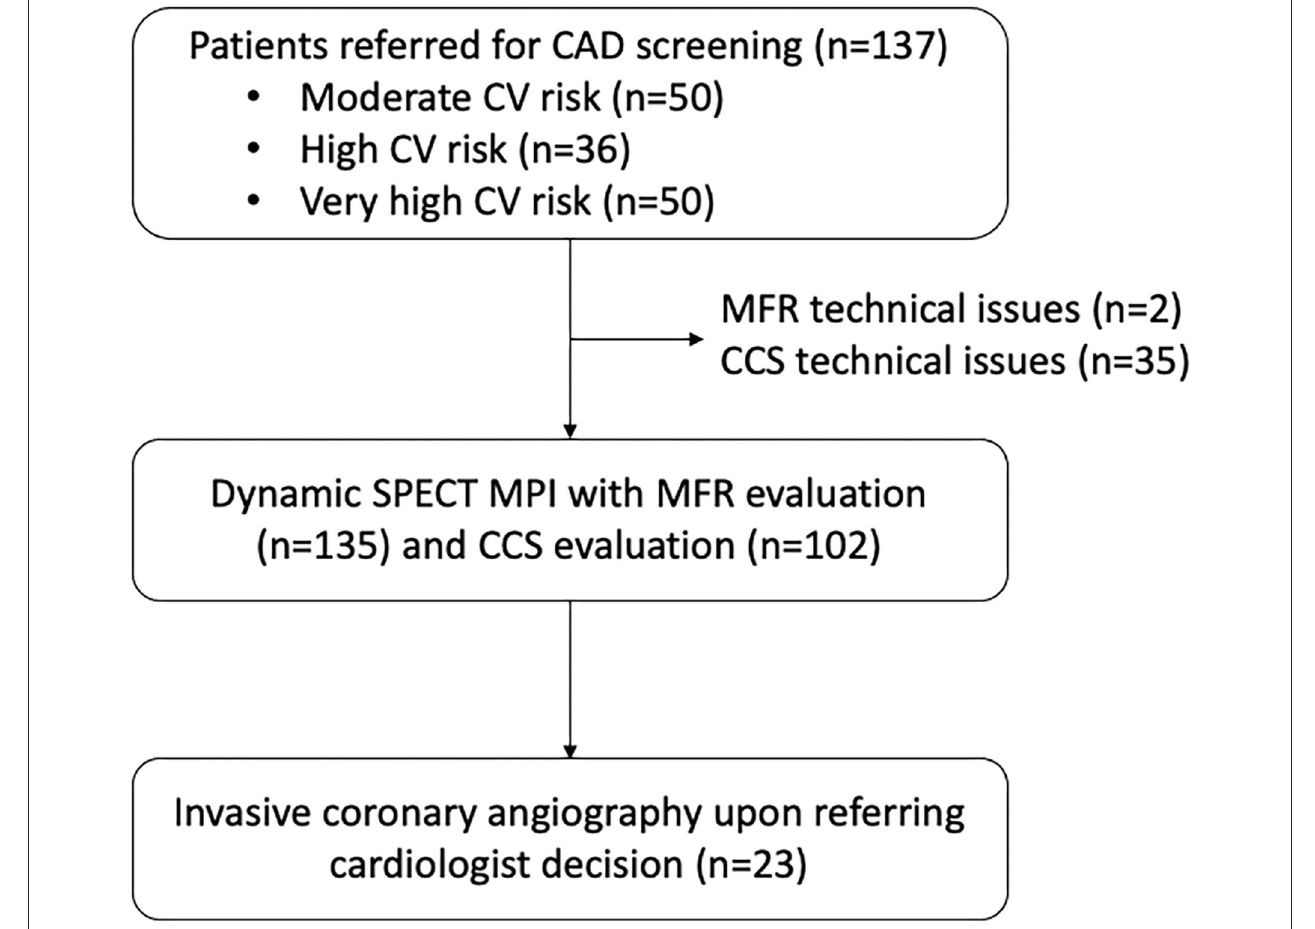
FIGURE 1 | Flow chart of the